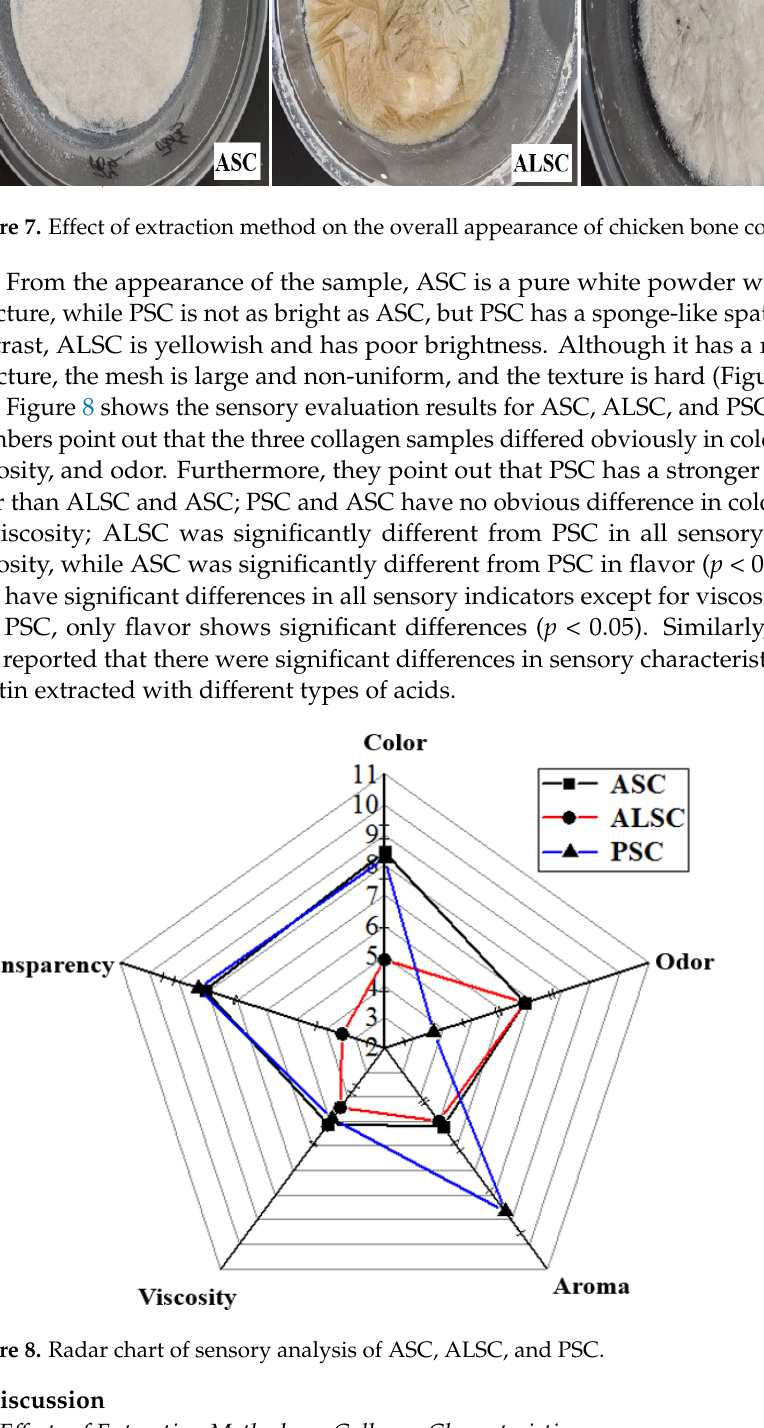
Table 5. Color of chicken collagen extracted by acid, alkali, and enzyme.